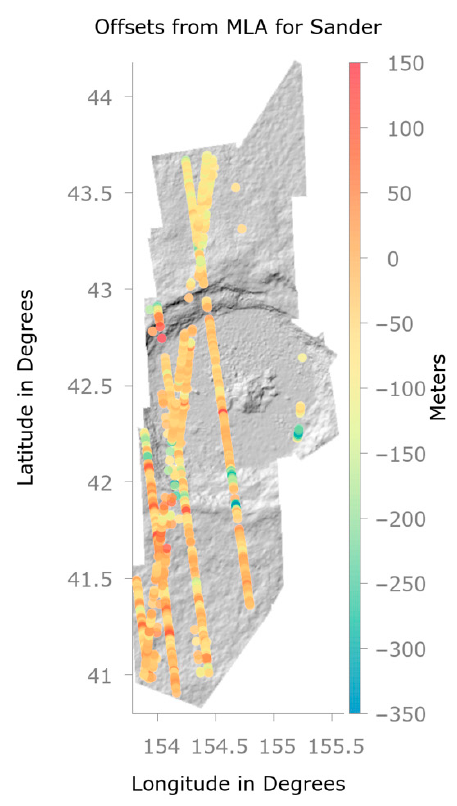
Figure 6. Plot showing the difference between MLA profiles and the Sander crater regional DEM. The DEM mosaic consists of 36 stereo pairs with a pixel scale of 162 m.